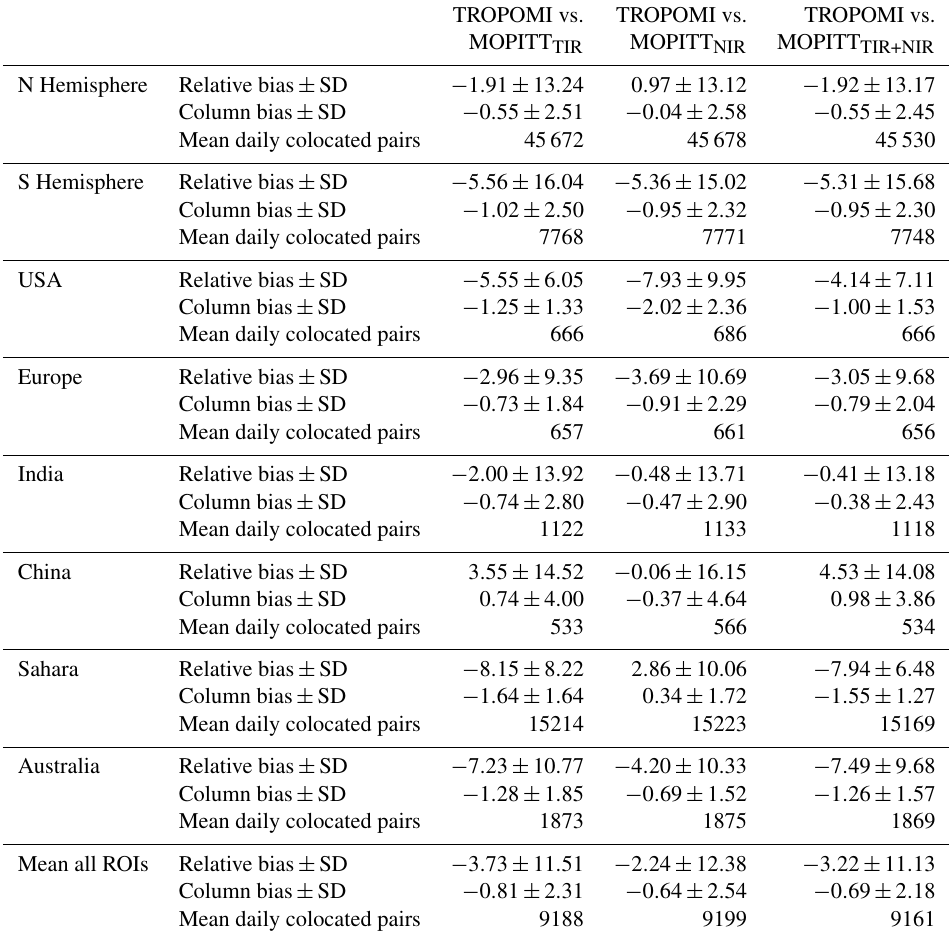
Table 1. Statistics from colocated TROPOMI vs. MOPITT CO retrievals over land for the period between 7 November 2017 and 10 March 2019. Relative bias and SD are in percent. Column bias and SD are in units of 10 17 moleccm − 2